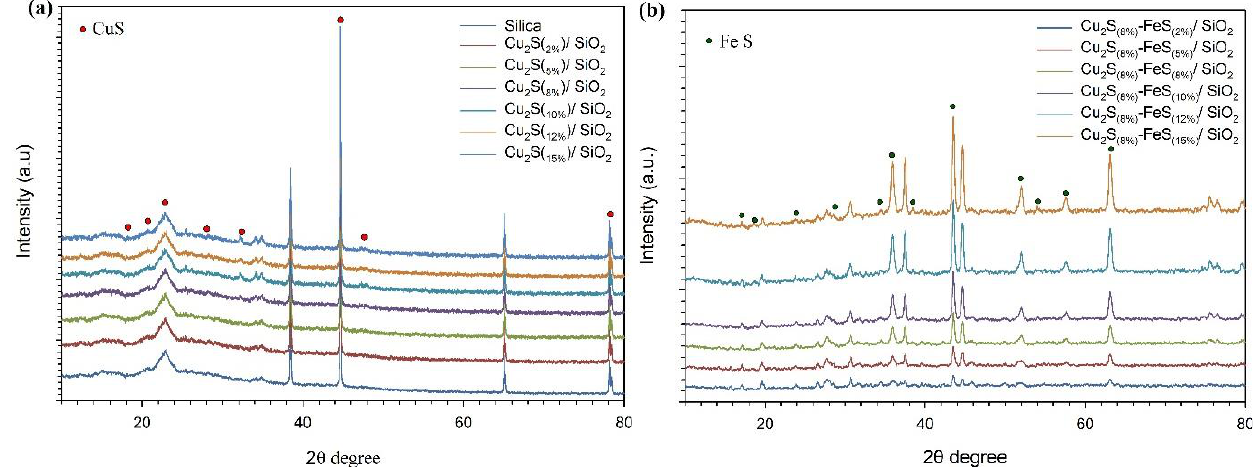
Figure 1. XRD pattern for the prepared samples. ( a ) XRD pattern for the monometallic catalysts (SiO 2 , Cu/SiO 2 , Fe/SiO 2 , Cu 2 S (2%) /SiO 2 , Cu 2 S (5%) /SiO 2 , Cu 2 S (8%) /SiO 2 , Cu 2 S (10%) /SiO 2 , Cu 2 S (12%) /SiO 2 , and Cu 2 S (15%) /SiO 2 ) and ( b ) XRD pattern for the bimetallic catalysts (Cu 2 S (8%) -FeS (2%) /SiO 2 , Cu 2 S (8%) -FeS (5%) /SiO 2 , Cu 2 S (8%) -FeS (8%) /SiO 2 , Cu 2 S (8%) -FeS (10%) /SiO 2 , Cu 2 S (8%) -FeS (12%) /SiO 2 , and Cu 2 S (8%) -FeS (15%) /SiO 2)